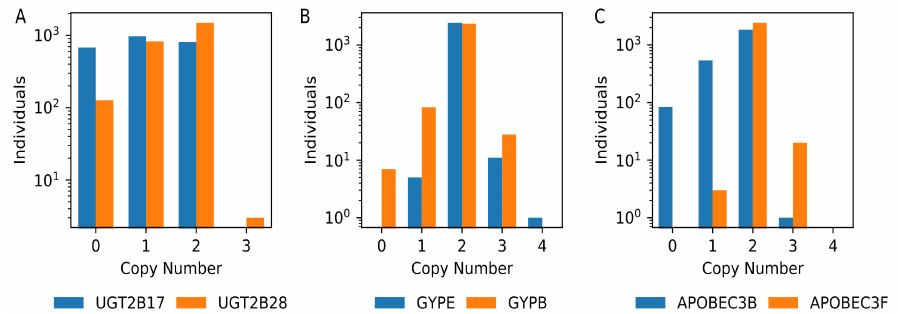
Figure 6. Illustrative copy number profiles for three sets of related gene paralogs. Histograms of gene copy number counts for 2457 individuals are shown for a subset of genes at the UGT2B locus ( A ), the glycophorin locus ( B ), and the APOBEC3 cluster ( C ). Note that the Y axis is plotted on a logarithmic